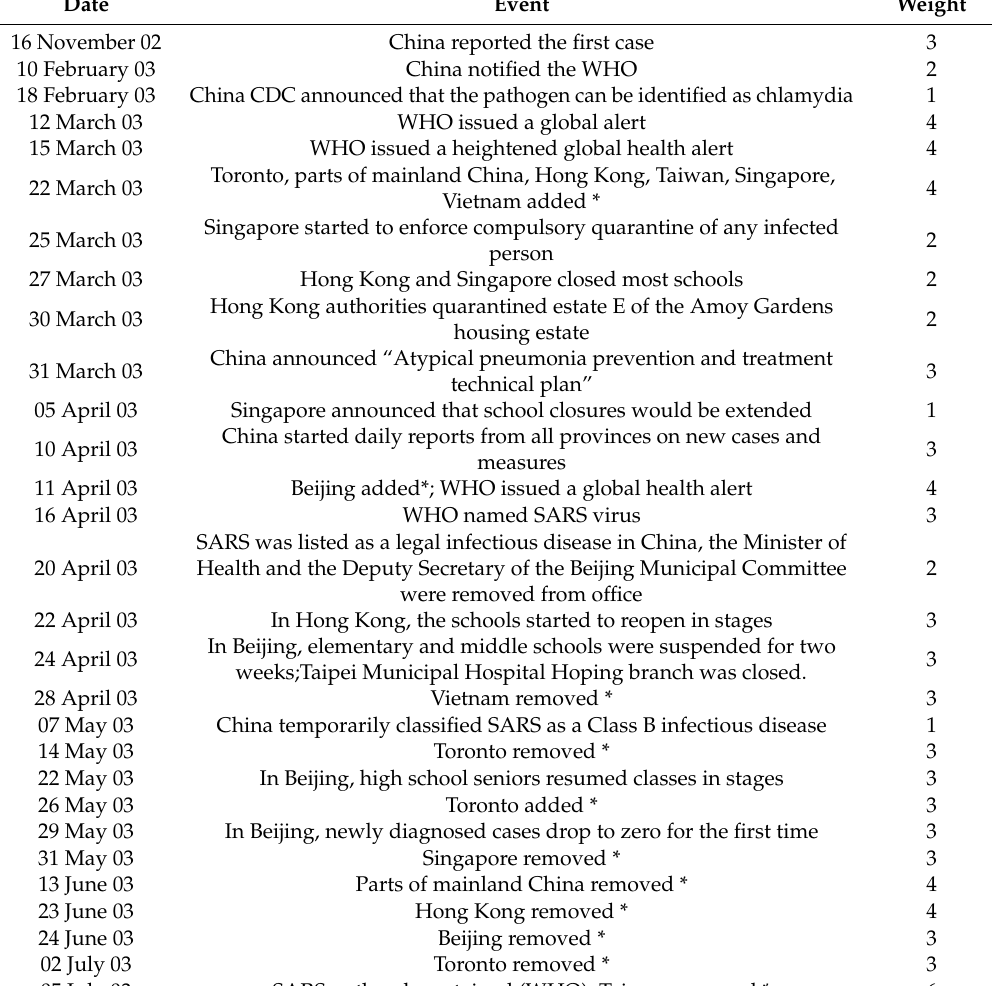
Table 5. Events during the SARS outbreak. (16 November 2002–05 July